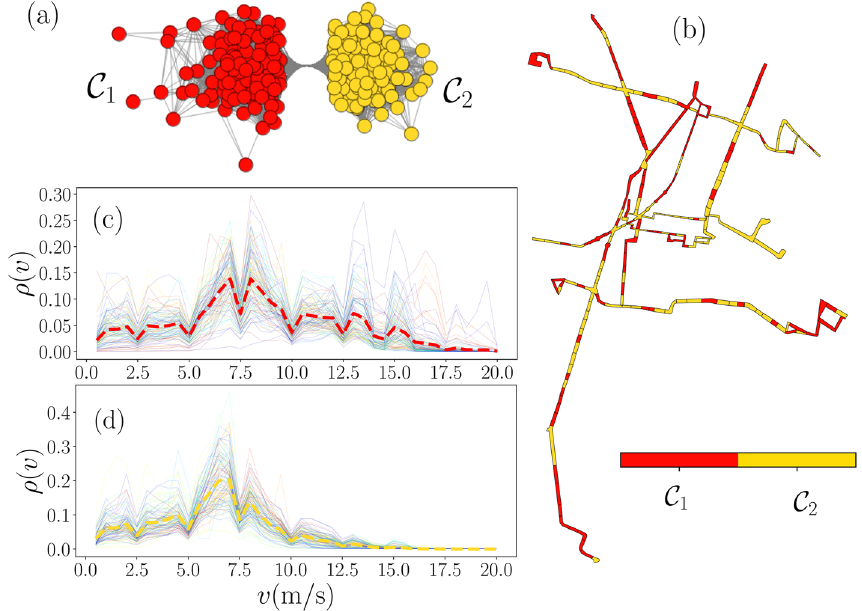
Figure 6. Community detection and activity of vehicles for similarity networks. ( a ) Similarity network with threshold value H = 0.357 with two communities C 1 and C 2 . ( b ) Segments map representing the communities. Probability densities ρ( v ) for the segments in C 1 ( c ) and C 2 ( d ). In panels ( c ) and ( d ), thin lines represent the ρ ( i ) ( v ) for each segment as in Fig. 2b and thick dashed lines depict the probability density found for all the total values of v in i ∈ C 1 and i ∈ C 2 . The network in panel ( a ) was generated using Mathematica 12.3.1 (https:// www.